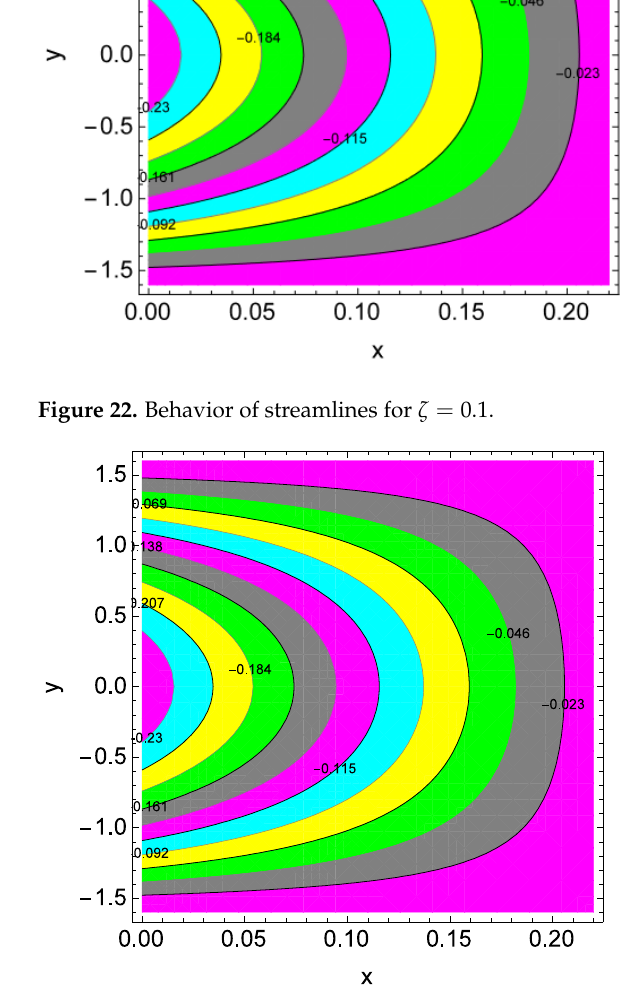
Figure 23. Behavior of streamlines for ζ =